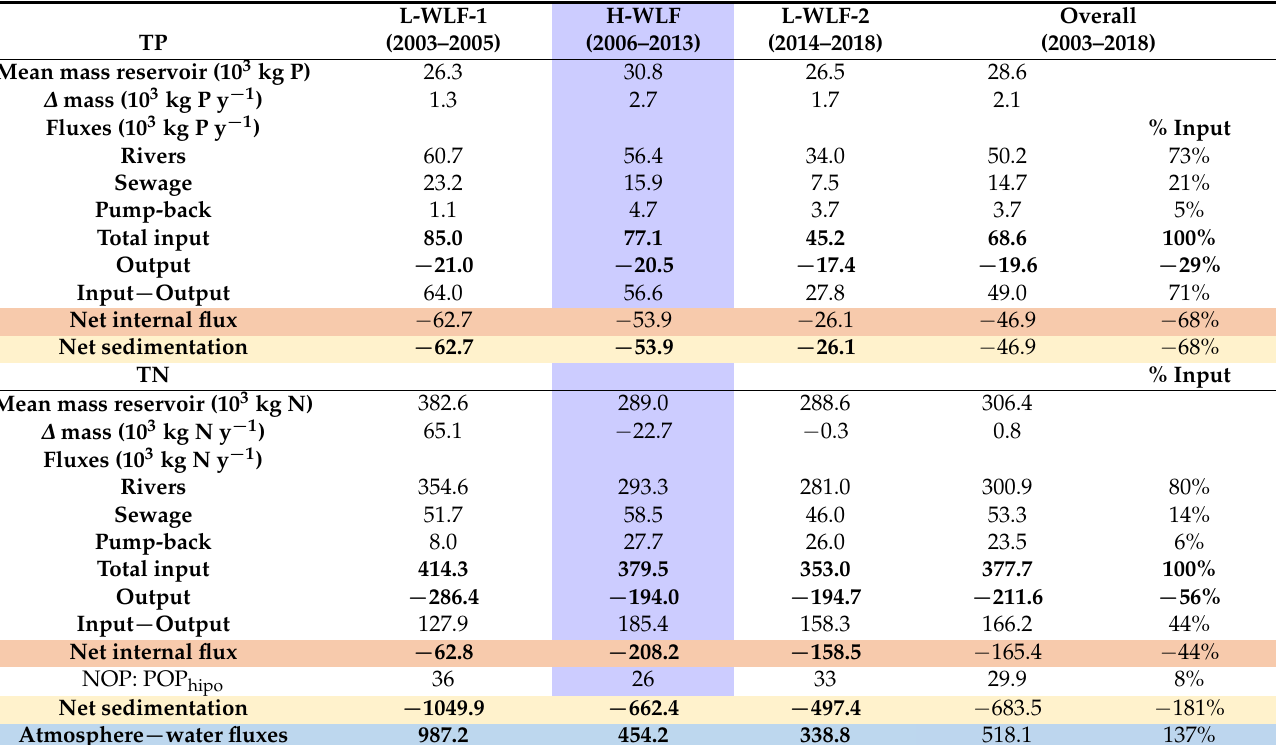
Table 1. Phosphorous and nitrogen budgets for Valle de Bravo during 2003–2018. Mean annual phosphorous (TP) and nitrogen (TN) budget components of Valle de Bravo are shown for: the low water level fluctuation-1 (L-WLF-1) period (2003–2005), the high water level fluctuation (H-WLF) period (2006–2013) (shaded in purple for better visualization), the water level fluctuation-2 (L-WLF-2) period (2014–2018), the overall means for the full study period (2003–2018) as well as the percentage of each flux relative to the total input. The net internal fluxes of P and N are shaded in orange, the net sedimentation fluxes are shaded in yellow, and the atmosphere − water fluxes of N are shaded in blue. L-WLF-1 H-WLF L-WLF-2